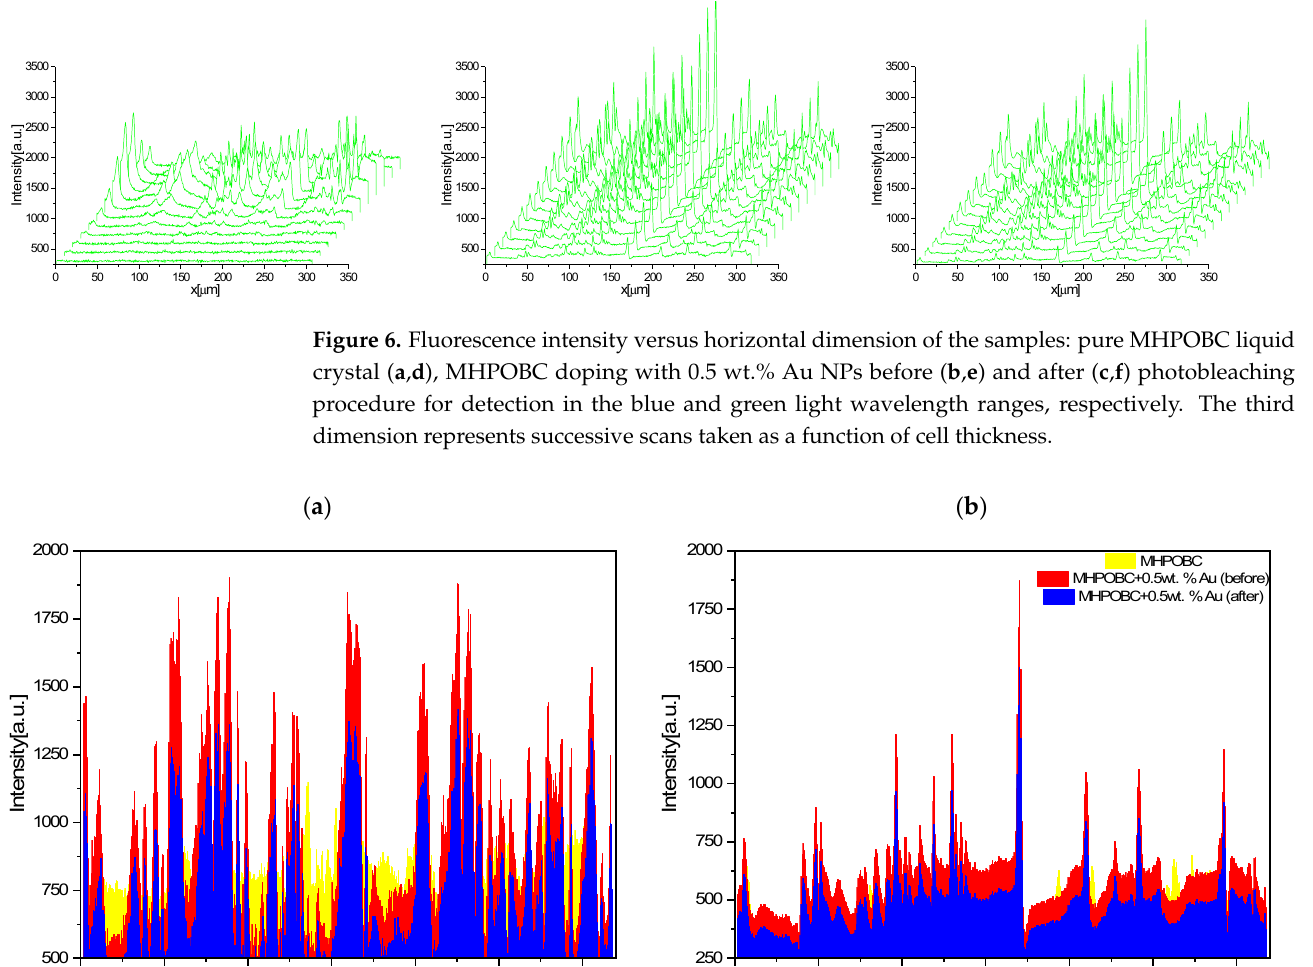
Figure 7. Fluorescence intensity versus horizontal dimension of pristine MHPOBC and MHPOBC doping with 0.5 wt.% Au NPs before and after photobleaching procedure, for detection in the blue ( a ) and green ( b ) light wavelength.